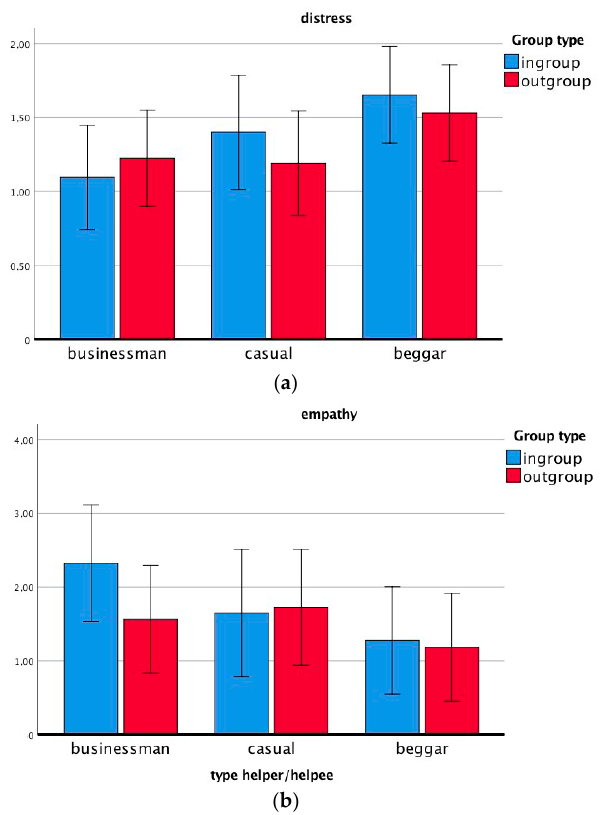
Figure 4. ( a ): Distress. The y-axis represents the mean of distress across the three conditions (confederate social appearance) reported on the x-axis, the color of the bars represents the variable confederate group type. Bar Errors +/ − 2 SE; ( b ) Empathy. The y-axis represents the mean of empathy across the three conditions (confederate social appearance) reported on the x-axis, the color of the bars represents the variable confederate group type. Bar Errors +/ − 2 SE.